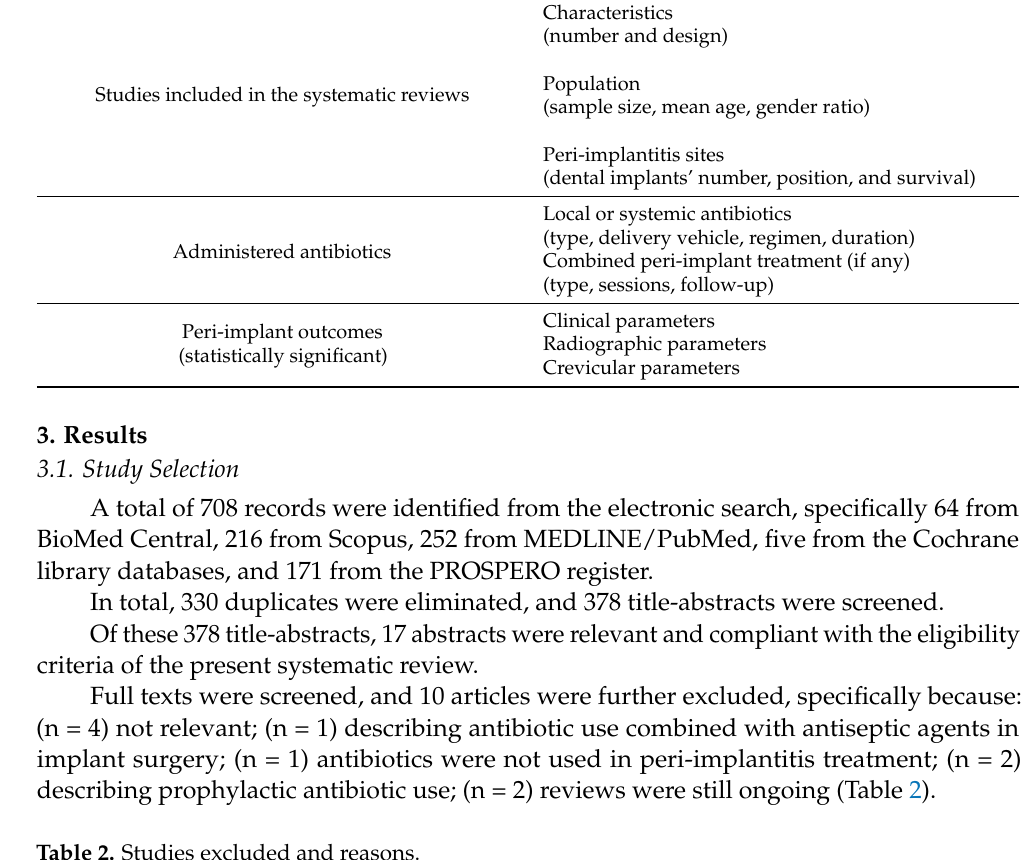
Table 2. Studies excluded and